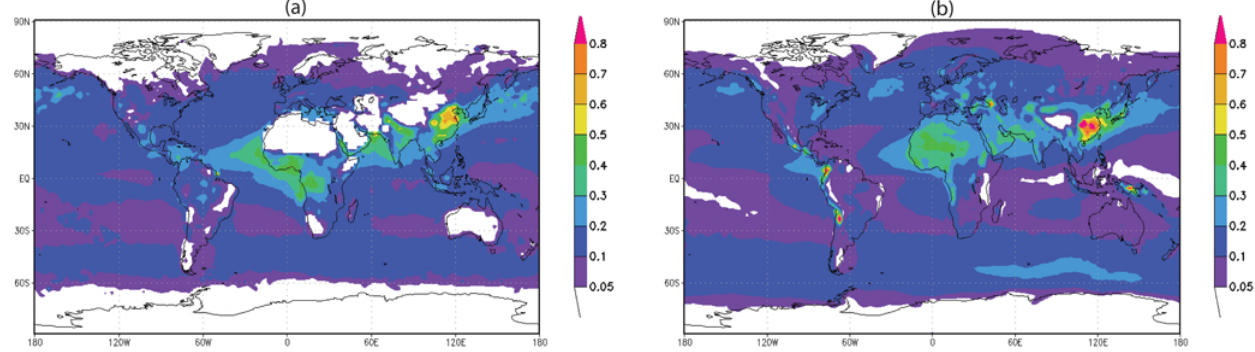
Fig. 3. Annual mean aerosol optical depth from (a) MODIS/Terra satellite observations (2001) and (b) model simulations with non-absorbing OC. The white color in panel (a) indicates areas over which satellite retrievals are not available.